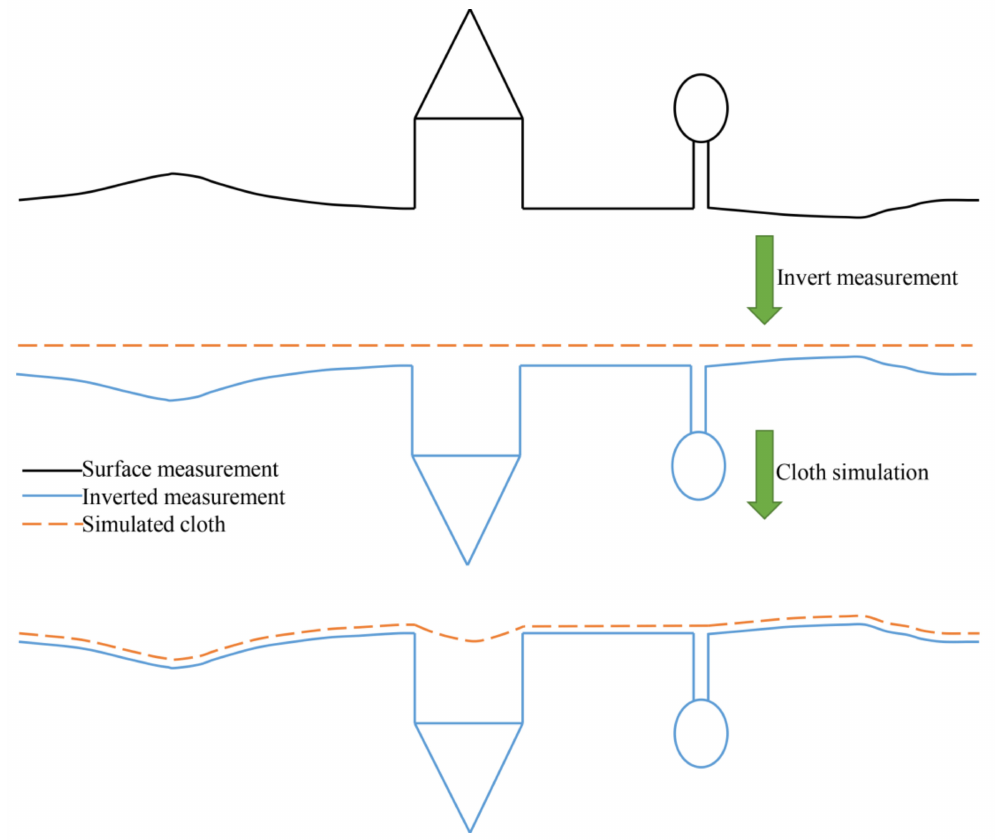
Figure 1. The process of cloth simulation